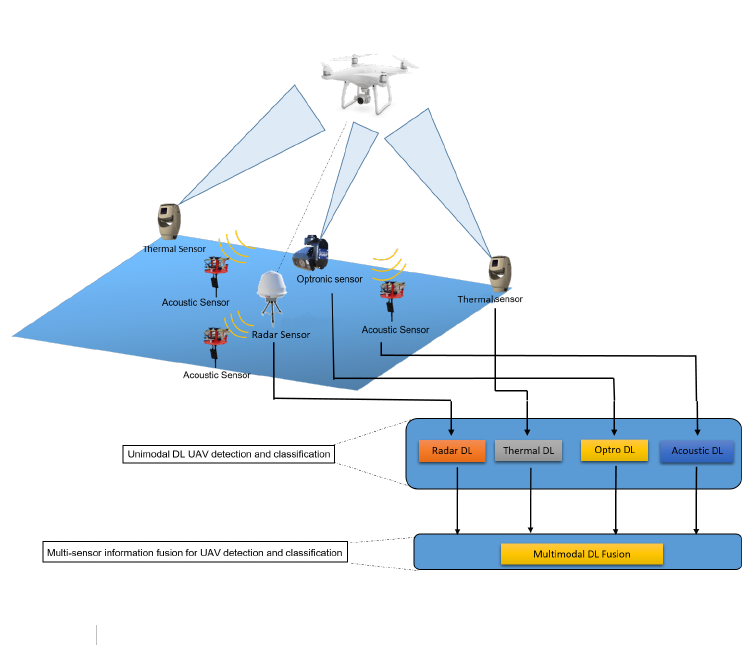
Figure 10. Recommended counter-UAV